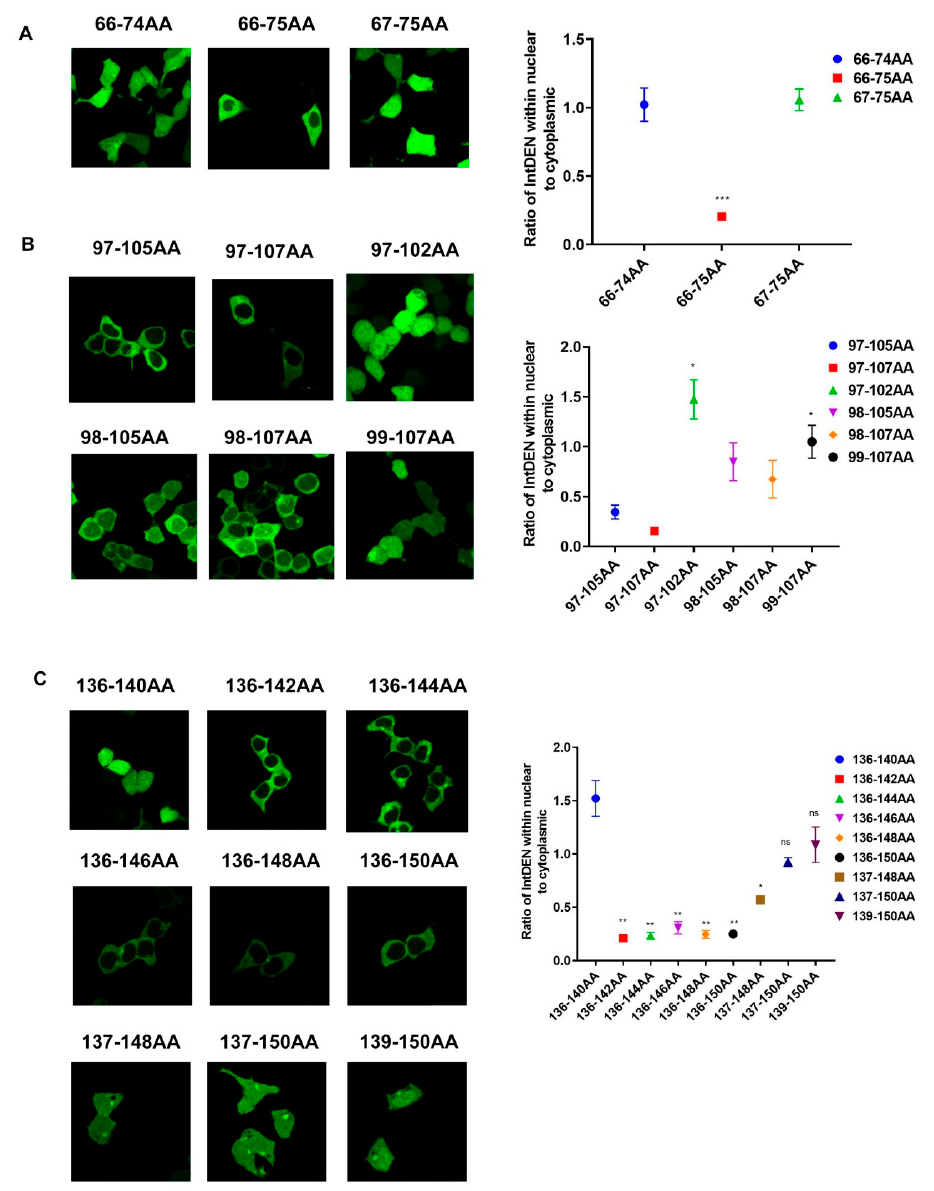
Figure 3. Identification of minimum NES motifs of IDV NS2 protein. ( A ) pCAGGS-eGFP-NES (66-75aa) and its truncated derivatives (66–74aa, 67–75aa) were transfected into HEK293T